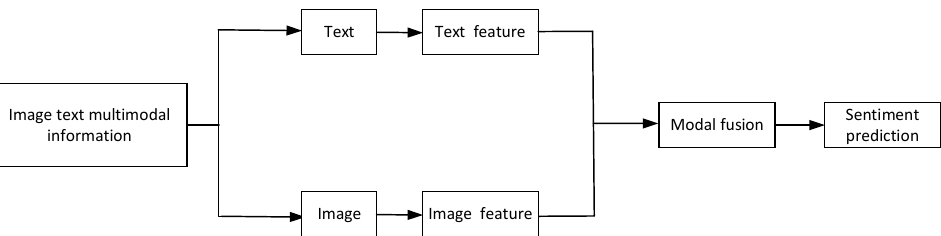
Figure 1. Illustration of Fusion method. The image and text are extracted by features for the multimodal information of image text corresponding to the model input, and the emotional polarity is judged after feature